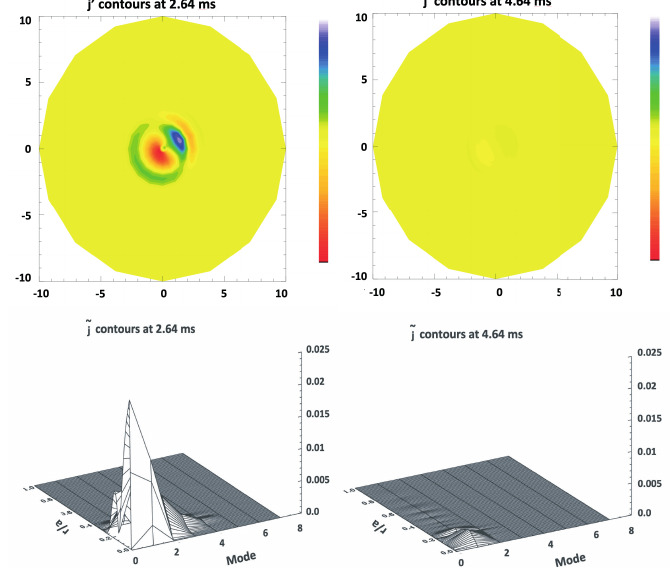
Figure 10. Top : The contour plots of the current density fluctuations ˜ j at t = 2.64 ms corresponding to the saturated level with M S = 0, Pr = 30 ( left ), and at t = 4.64 ms with M S = 10 − 1 , Pr = 1 ( right ). Bottom : The corresponding spectra of the current density fluctuations ˜ j as functions of ρ and poloidal mode number m , at t = 2.64 ms ( left ) and t = 4.64 ms ( right